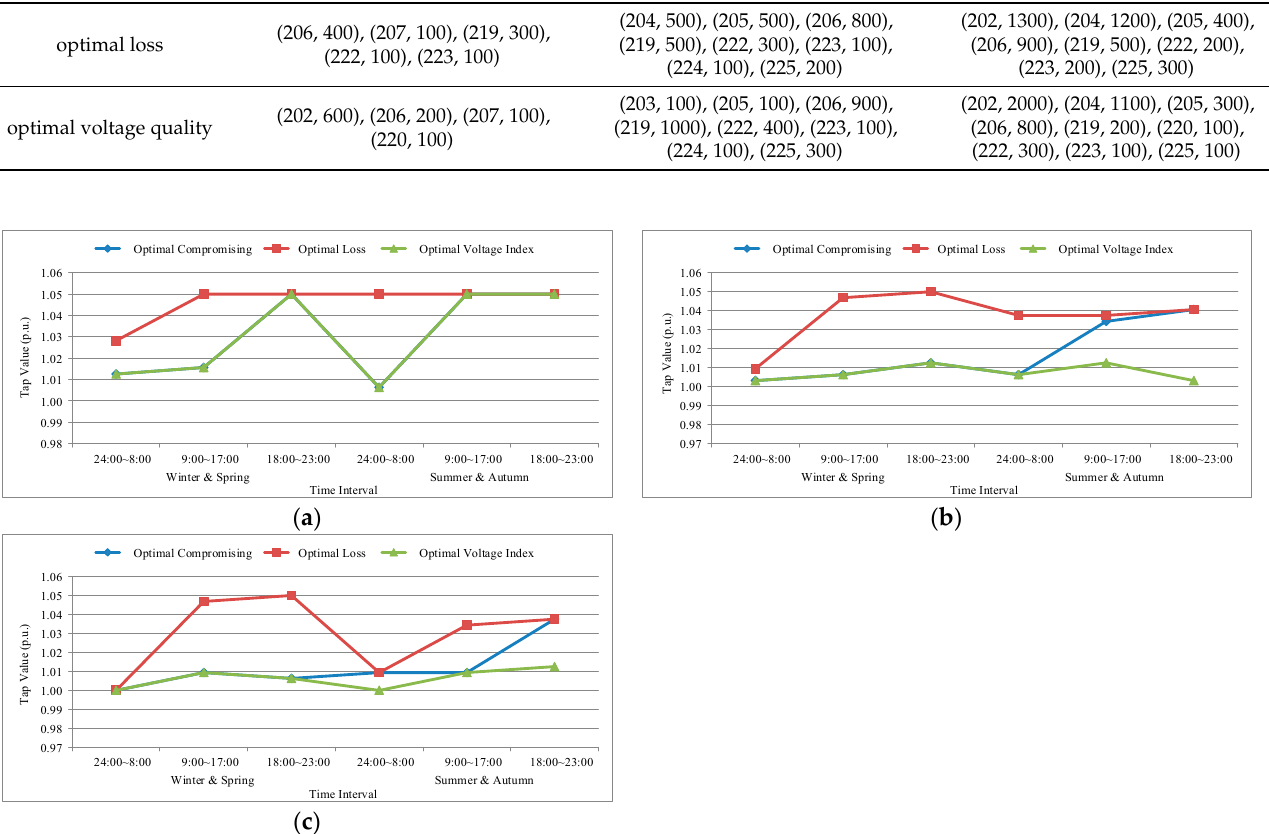
Figure 12. Tap values for different objectives of the Feeder1-Based simulation. ( a ) PV installed capacity 1000 kW; ( b ) PV installed capacity 3000 kW; ( c ) PV installed capacity 5000 kW.